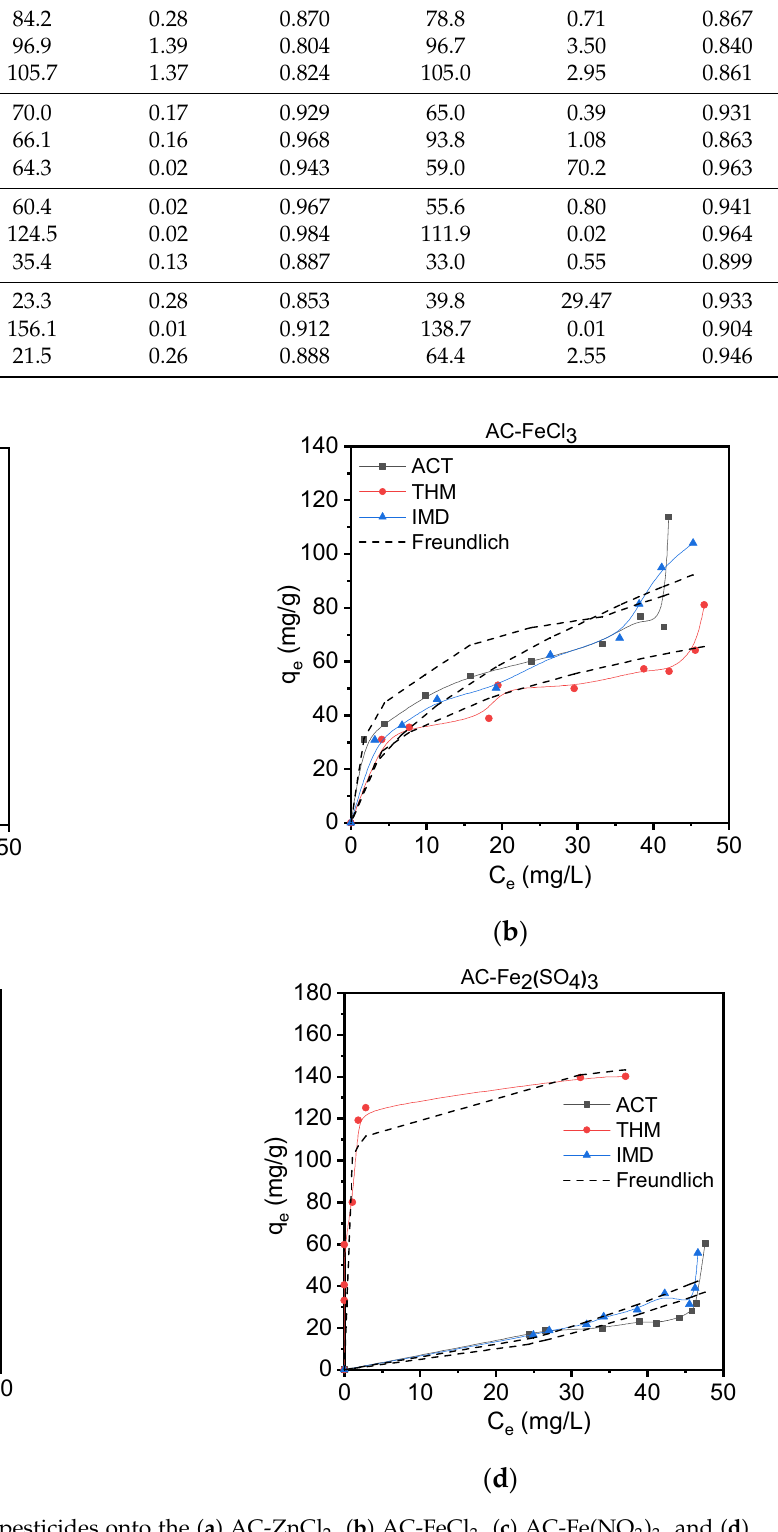
Figure 4. Adsorption isotherms of the three pesticides onto the ( a ) AC-ZnCl 2 , ( b ) AC-FeCl 3 , ( c ) AC-Fe(NO 3 ) 3 , and ( d ) AC- Fe 2 (SO 4 ) 3 activated carbons.